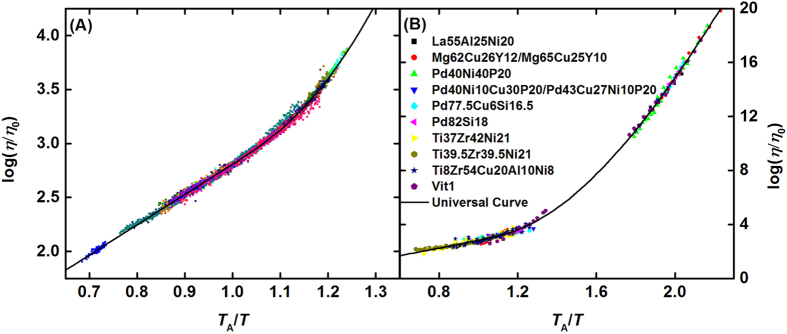
(A) Collapse of viscosity data from Fig. 1 onto a universal curve assuming the avoided critical point form (KKZNT, black curve). Supplementary Figure 2 shows the residuals of the fit. (B) Data collapse of measurements reported in this work and for literature data for additional metallic glass-forming liquids. See Supplementary Table 2 for references to the data for the additional liquids broken down by composition.